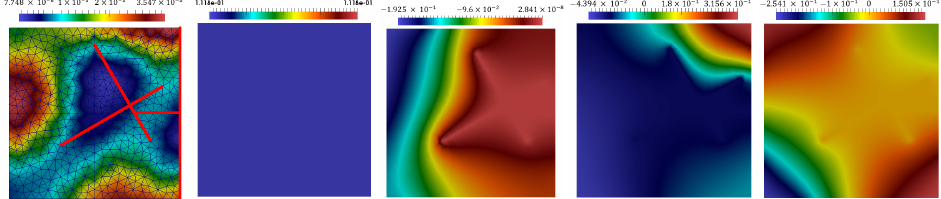
Figure 3. An example of the first four eigenvectors for pressure in a local domain ω l with fractures in a heterogeneous local